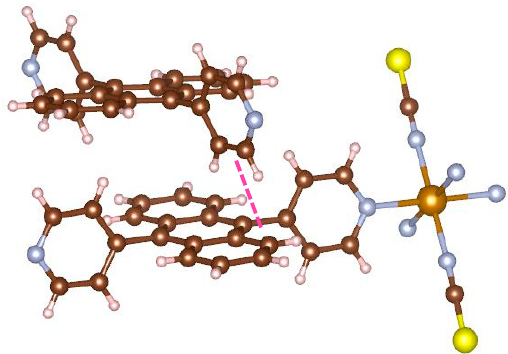
Figure 6. CH– π interaction between 2D grids.